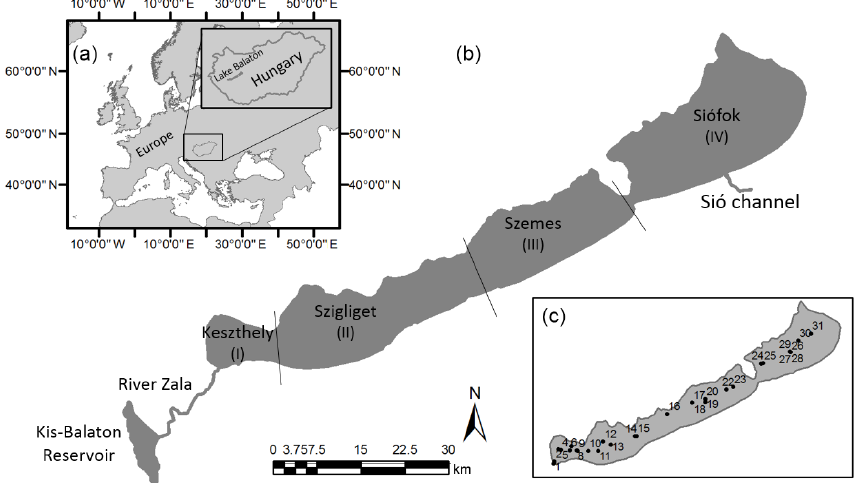
Figure 1. (a) Location of Lake Balaton within Europe. (b) Map of basins, Kis-Balaton reservoir, Zala River and Sió channel. (c) Location of 31 sampling stations in Lake